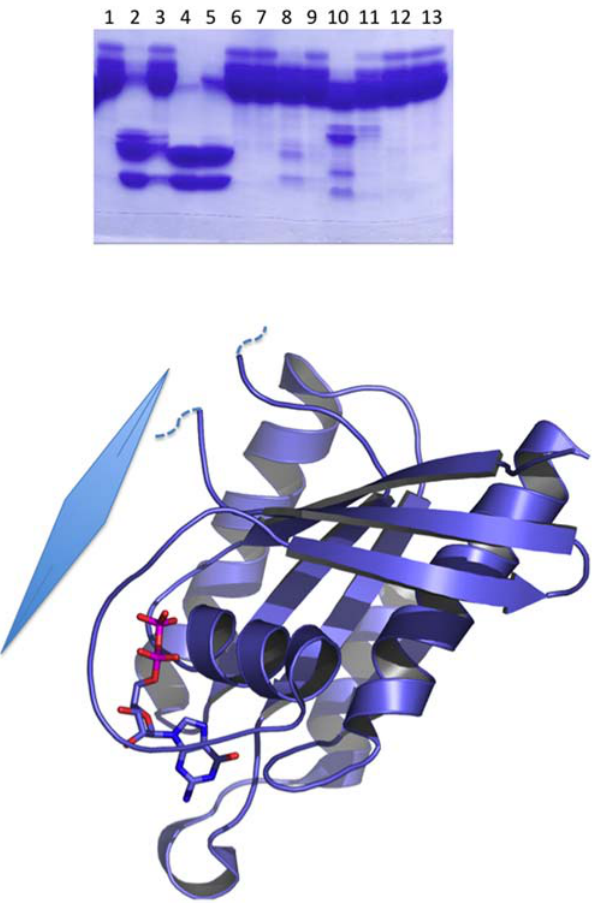
Figure 1. CGD6_3220 proteolytic digestion and subsequent crystal structure. (A) SDS-PAGE gel, lane 1 is untreated protein. Following lanes consist of two concentrations each of chymotrypsin, Trypsin, Elastase, Papain, Subtilisin, and V respectively. Note both chymotrypsin and trypsin yield 2 large stable domains. (B) Ribbon diagram of CGD6_3220. Dotted lines signify missing density, large diamond represents plane of crystal packing.